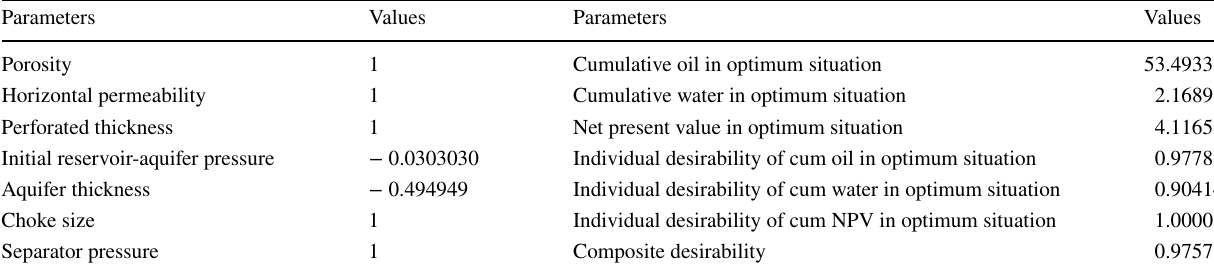
Table 15 Multiobjective optimization results using a proxy model made for each of the target functions